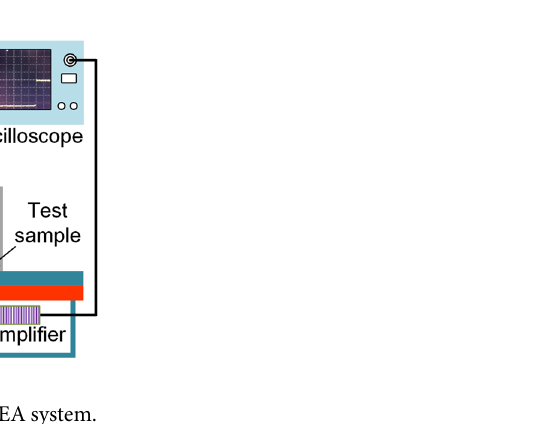
Figure 10. ( a ) The temperature gradient distribution under temperature from 20 °C to 120 °C and ( b ) the schematic illustration of the potential detecting system.